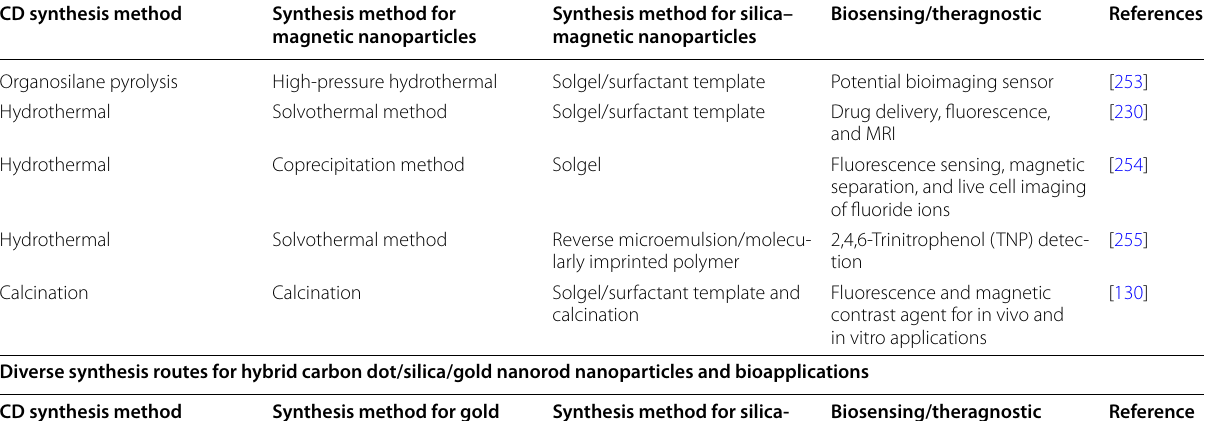
Table 6 Diverse synthesis routes for hybrid carbon dot/silica/magnetic nanoparticles and